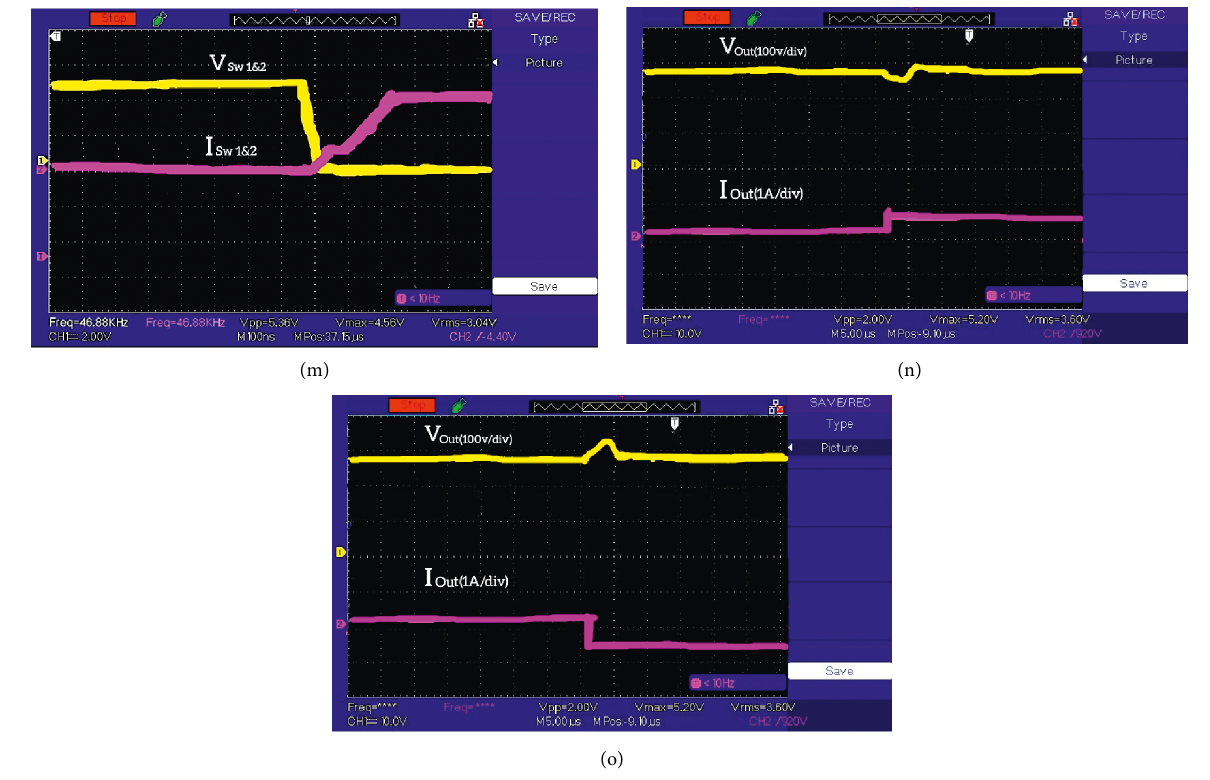
Figure 13: Experimental results: (a) driving signals of the power switches, S 1 and S 2 ; (b) voltage stress of the power switches, S 1 and S 2 ; (c) input voltage and the output voltage, V i and V o ; (d) voltages of diodes, D 1 and D 2 ; (e) voltages of diodes, D 3 and D 4 ; (f) voltages of diodes, D 5 and D 6 ; (g) voltages of capacitors, C 1 to C 3 ; (h) voltages of capacitors, C 4 and C 5 . (i) currents of diodes, D 1 and D 2 ; (j) currents of diodes, D 3 and D 4 ; (k) The currents of diodes, D 5 and D 6 ; (l) primary winding currents of the coupled inductors; (m) voltage and current of power switches in ZCS conditions; (n) dynamic response for load increase; (o) dynamic response for load decrease.